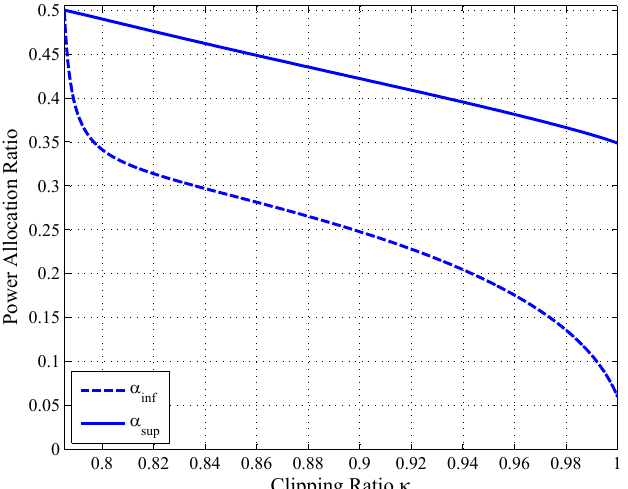
Figure 1. The approximate CCDF and empirical CCDF of PAPR of an OFDM-NOMA system with 128 and 1024 subcarriers.